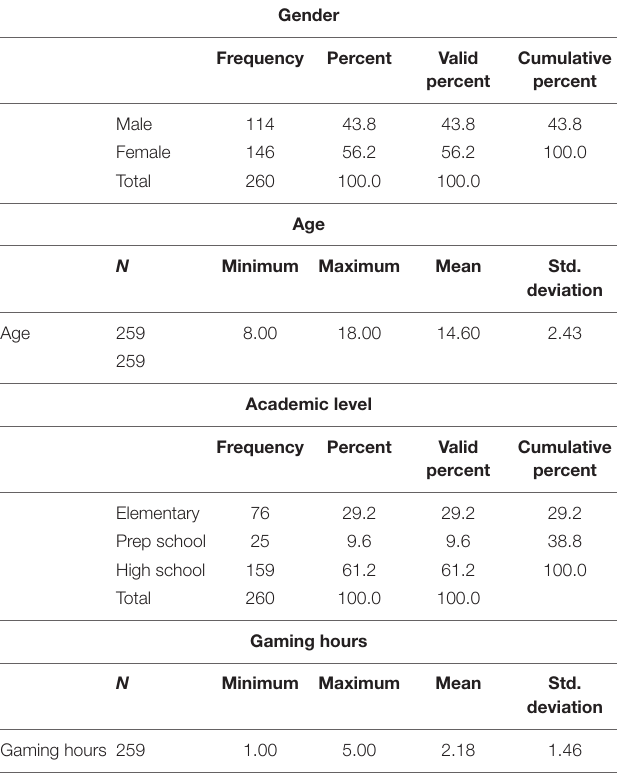
TABLE 1 | Descriptive statistic for